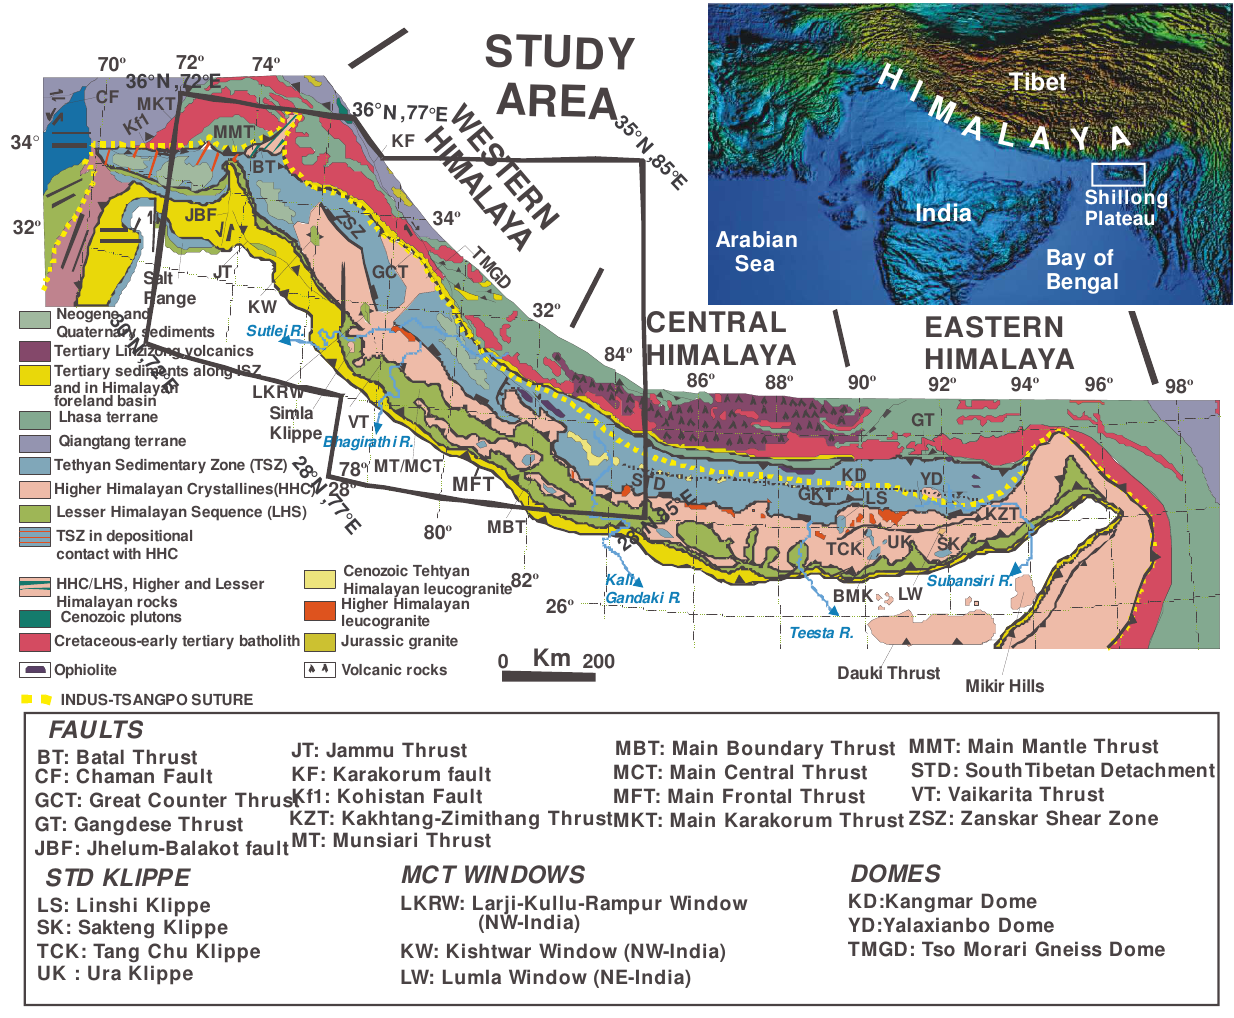
Fig. 1. The tectonic map (modified from Yin, 2006; Yin et al., 2010) and study area shown in grid.